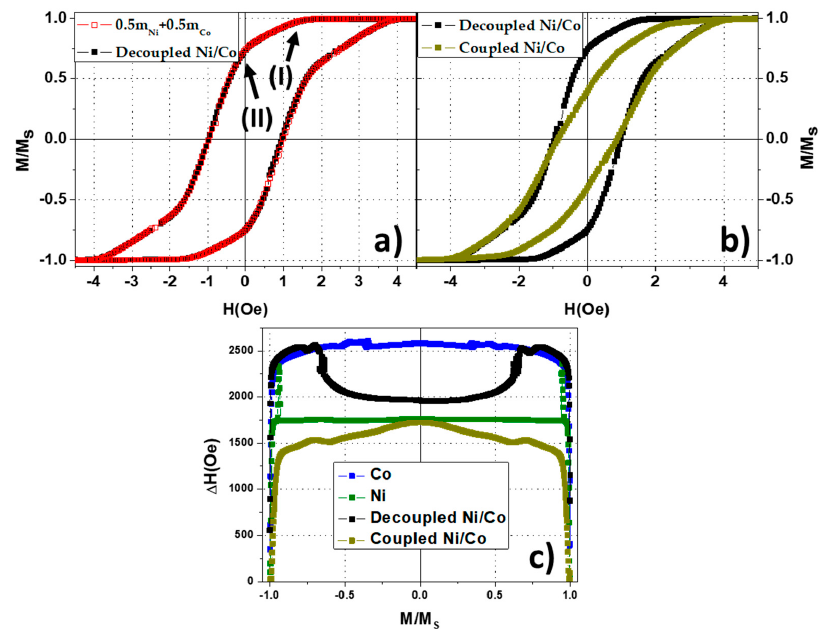
Figure 5. ( a ) Numerical superposition of the Co and Ni room temperature hysteresis loops (red open symbols) compared to the decoupled Ni/Co hysteresis loop (black). ( b ) Comparison between the decoupled (black) and coupled (yellow) hysteresis loops. ( c ) Comparison of the hysteresis shape plots (width of hysteresis loops at different values of magnetization.